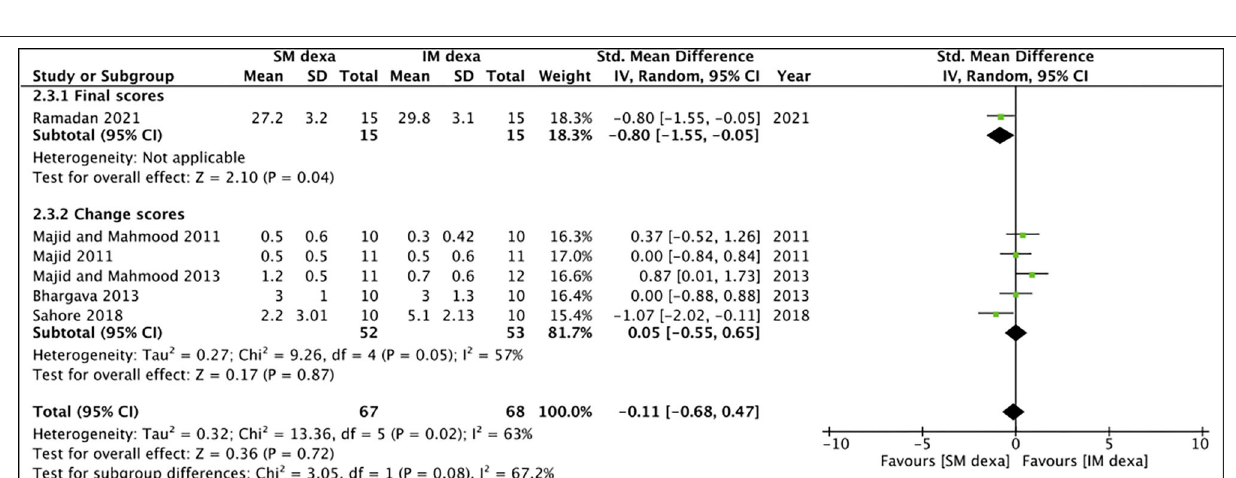
Frontiers in Surgery |